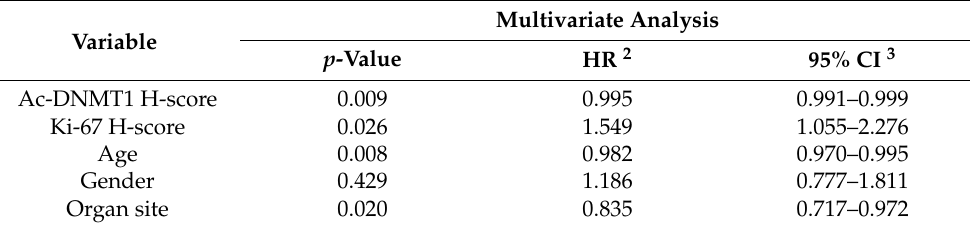
Table 5. Multivariate analyses including ac-DNMT1 and Ki-67 protein levels for 4-year MSS 1 in stage IV melanoma